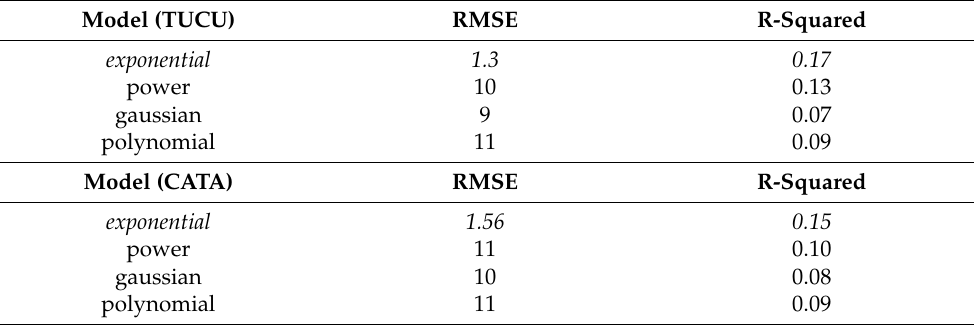
Figure 6. Quantile–Quantile plot on a log e scale of rainfall vs. GNSS-integrated water vapour shows that most of the data are well correlated when the log e (TRMM rainfall) vs. GNSS-IWV is considered in both stations ( A ) for TUCU and ( B ) for CATA. Below the 10th percentile, rainfall and GNSS-IWV do not follow an identical distribution at both stations. Black dashed lines indicate the rainfall percentiles (the 10th and 90th percentiles). Table 1. Comparing the quality of the fits for rainfall vs. GNSS-IWV based on RMSE and R-squared values for TUCU (top) and CATA (bottom) for different fitting models. The best-fit results are marked in italic